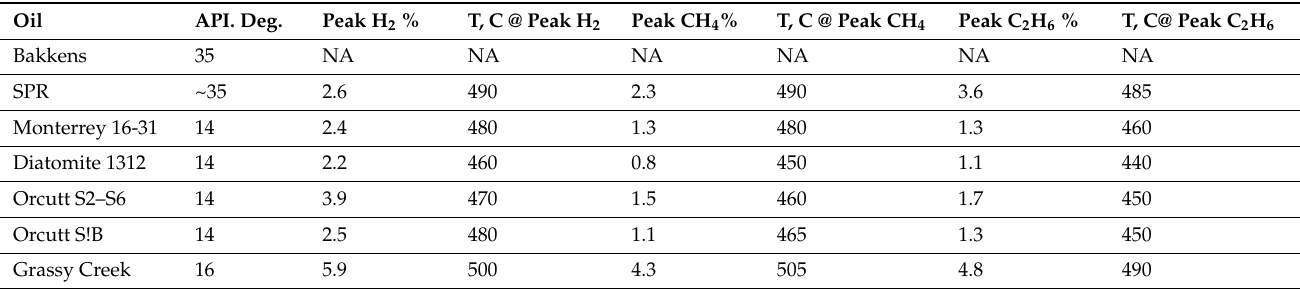
Table 2. Summary of results for oil